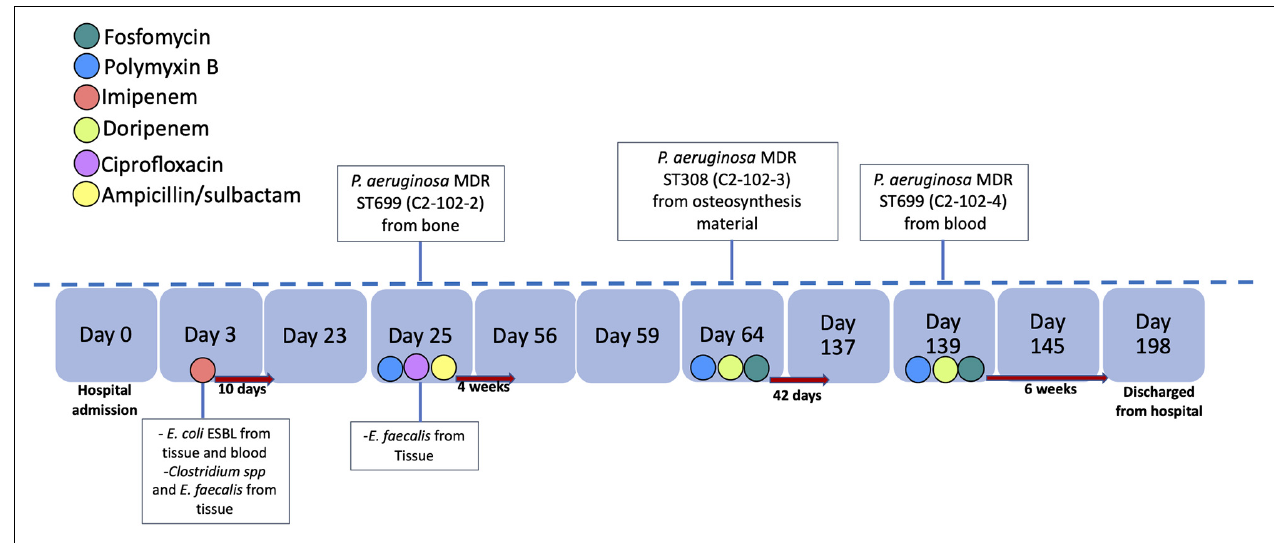
FIGURE 3 | Timeline of antimicrobial treatment and bacterial identification. The antibiotics are indicated by color and the time of treatment with a red arrow to the right. We indicate the bacteria and source of isolation in the day of identification.